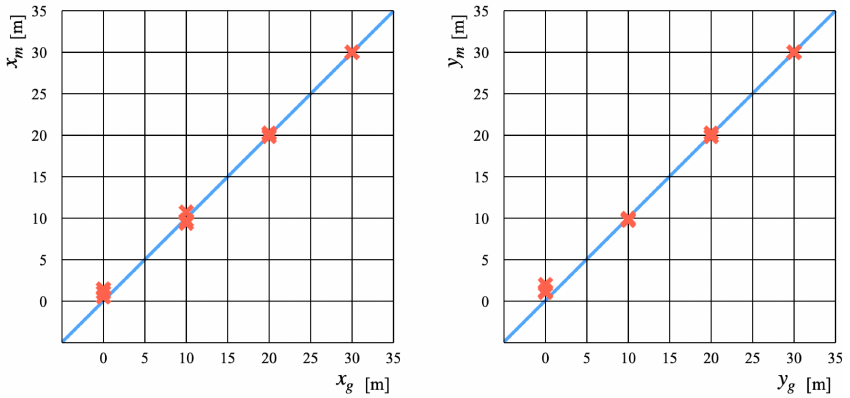
Figure 14. Scatter plots showing the GT coordinates and estimated coordinates for Experiment